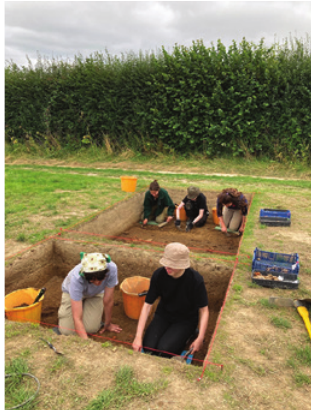
Figure 2 Student field course in 2021 (Source: photograph by Charlotte